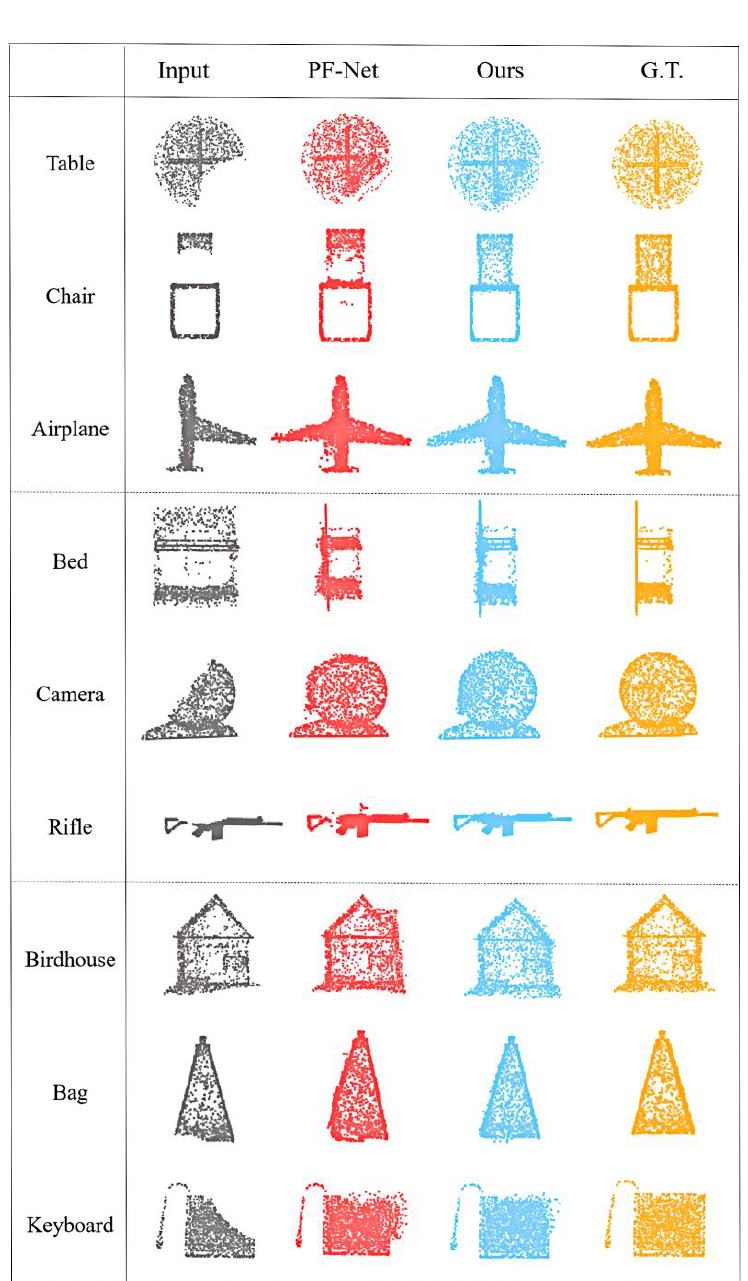
Figure 7. Qualitative results on ShapeNet-55. Point cloud completion results of our method and PF-Net on some objects from the simple, moderate, and hard classes.